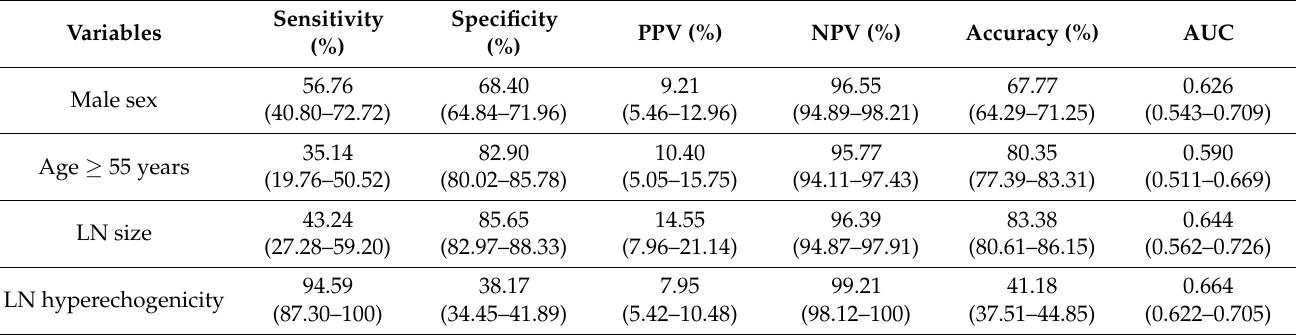
Table 5. Diagnostic performance of clinical and ultrasound imaging features for predicting recurrence in patients with N1b papillary thyroid